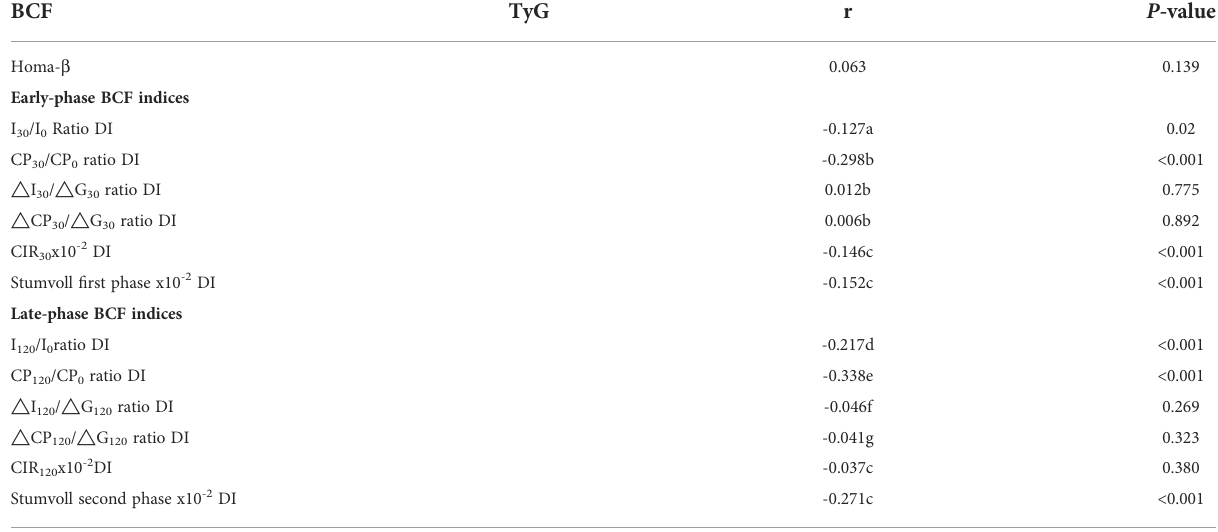
TABLE 2 Association between TyG index and b -cell function in all